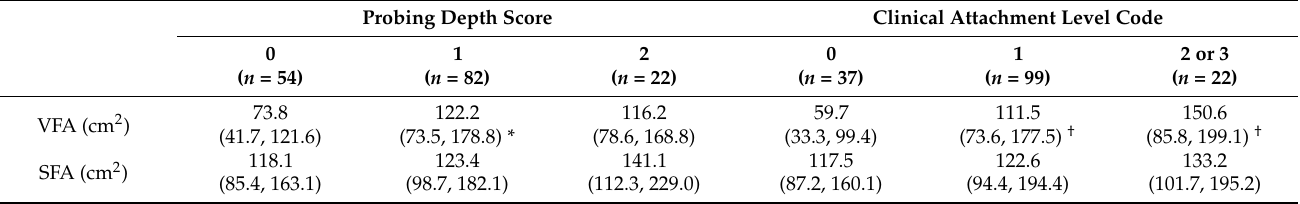
Table 2. Differences in VFA and SFA condition according to periodontal condition. Probing Depth Score Clinical Attachment Level